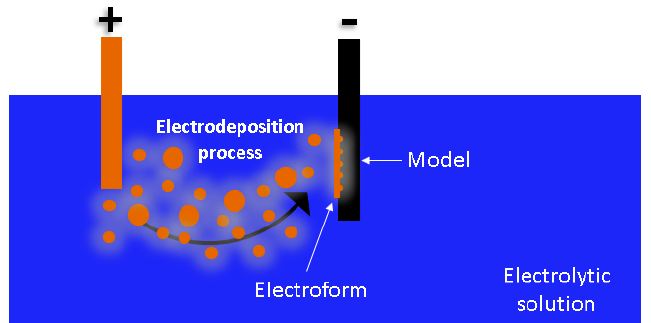
Figure 1. Schematic illustration of electroforming process.